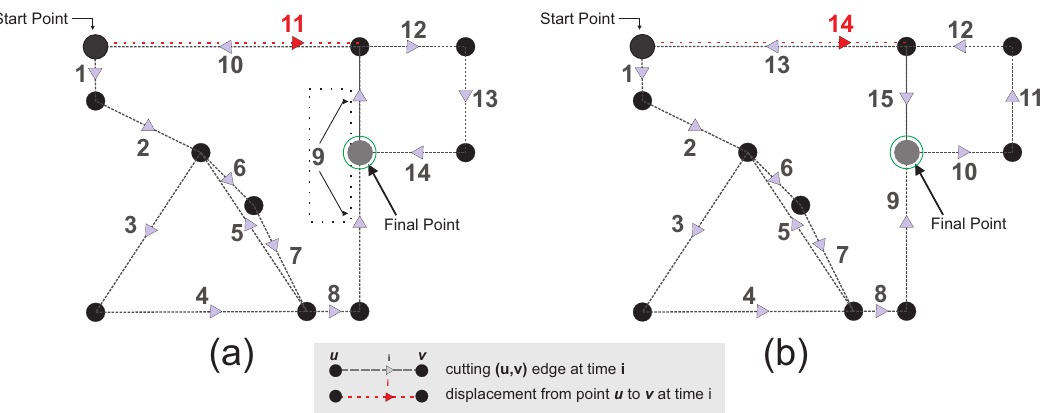
Figure 5. Examples of cut path for the layout in Figure 3. ( a ) A example of possible paths with 11 simple moves. ( b ) A example of possible paths with 14 simple